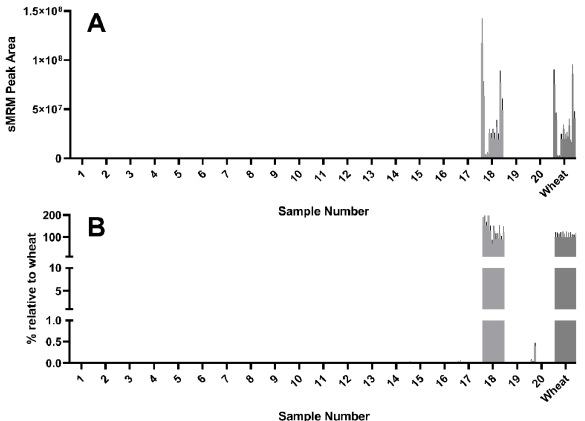
Figure 3. Detection of wheat marker peptides by LC–MS. Significant levels of wheat were detected in samples 17, 18, and 20, with trace levels in samples 1, 3, 5, 12, 14, 15, and 19. ( A ) LC–MS / MS peak area of the 12 wheat peptides used as peptide markers for wheat (raw data). ( B ) Peak area normalized to wheat control, expressed as a